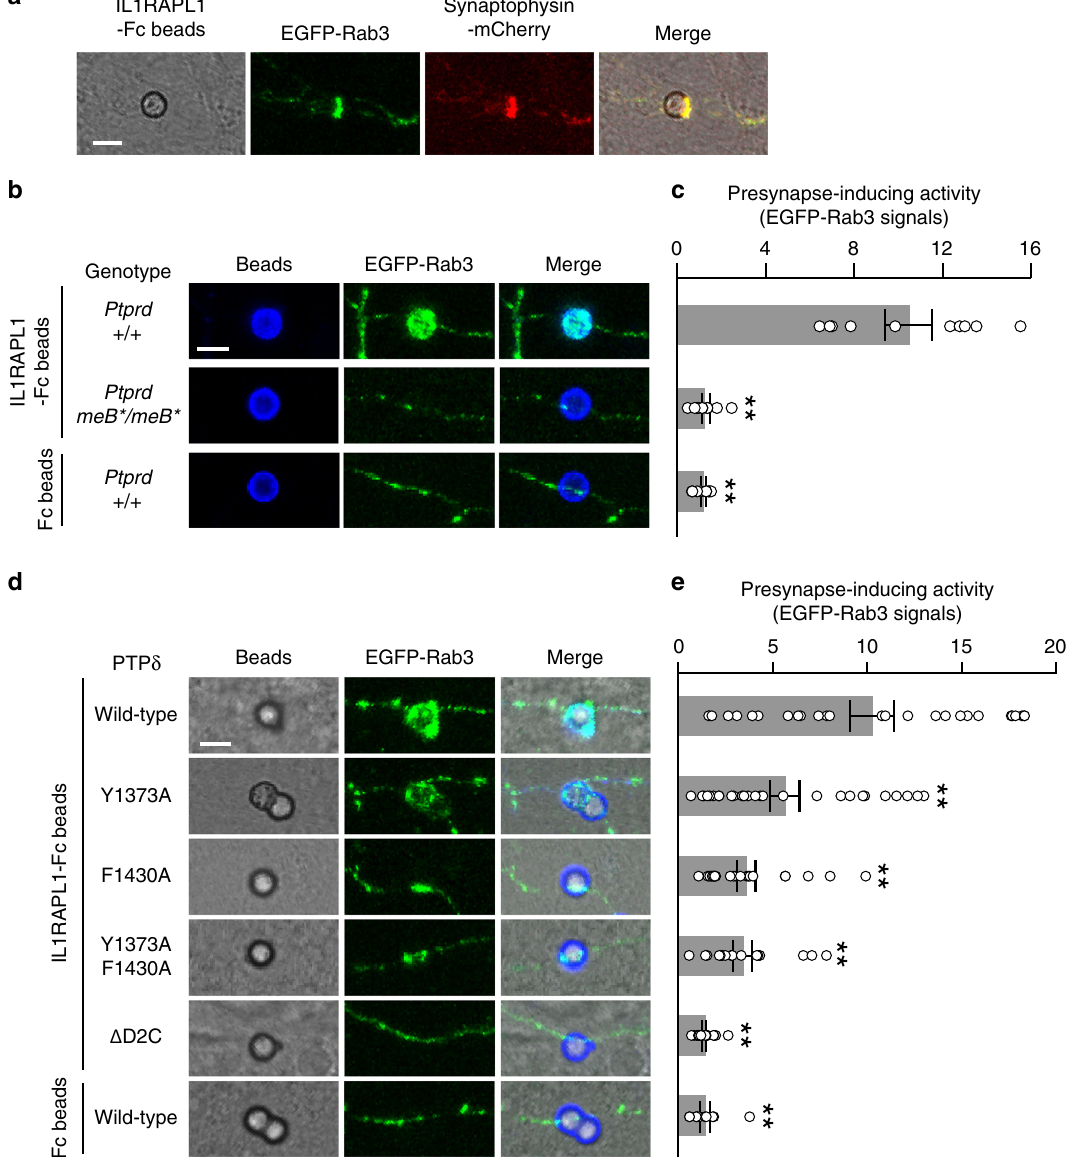
Fig. 4 Synaptogenic activities of PTP δ mutants impairing Liprin interaction. a IL1RAPL1-induced presynaptic differentiation of wild-type cortical neurons monitored by accumulation of EGFP-Rab3 (green) and synaptophysin-mCherry (red). b Complete loss of presynapse-inducing activity of IL1RAPL1 in cortical neurons from Ptprd meB*/meB* mutant mice. c Relative intensity of EGFP-Rab3 signals on the surface of beads in b ( n = 10 beads each). d Rescue of IL1RAPL1-induced EGFP-Rab3 accumulation in Ptprd meB*/meB* cortical neurons by transient expression of wild-type and mutated forms of PTP δ . e Relative intensity of EGFP-Rab3 signals on the surface of beads in d ( n = 27, 27, 22, 17, and 18 IL1RAPL1-Fc beads for wild type, Y1373A, F1430A, Y1373A/F1430A, and Δ D2C, respectively; n = 11 Fc beads for wild type). All values represent mean ± SEM. ** P < 0.01 compared with wild-type neurons with IL1RAPL1 beads in b and compared with neurons rescued by wild-type PTP δ and cocultured with IL1RAPL1 beads in d ; Tukey ’ s test. Scale bars, 5 μ m. Source data are provided as a Source Data fi